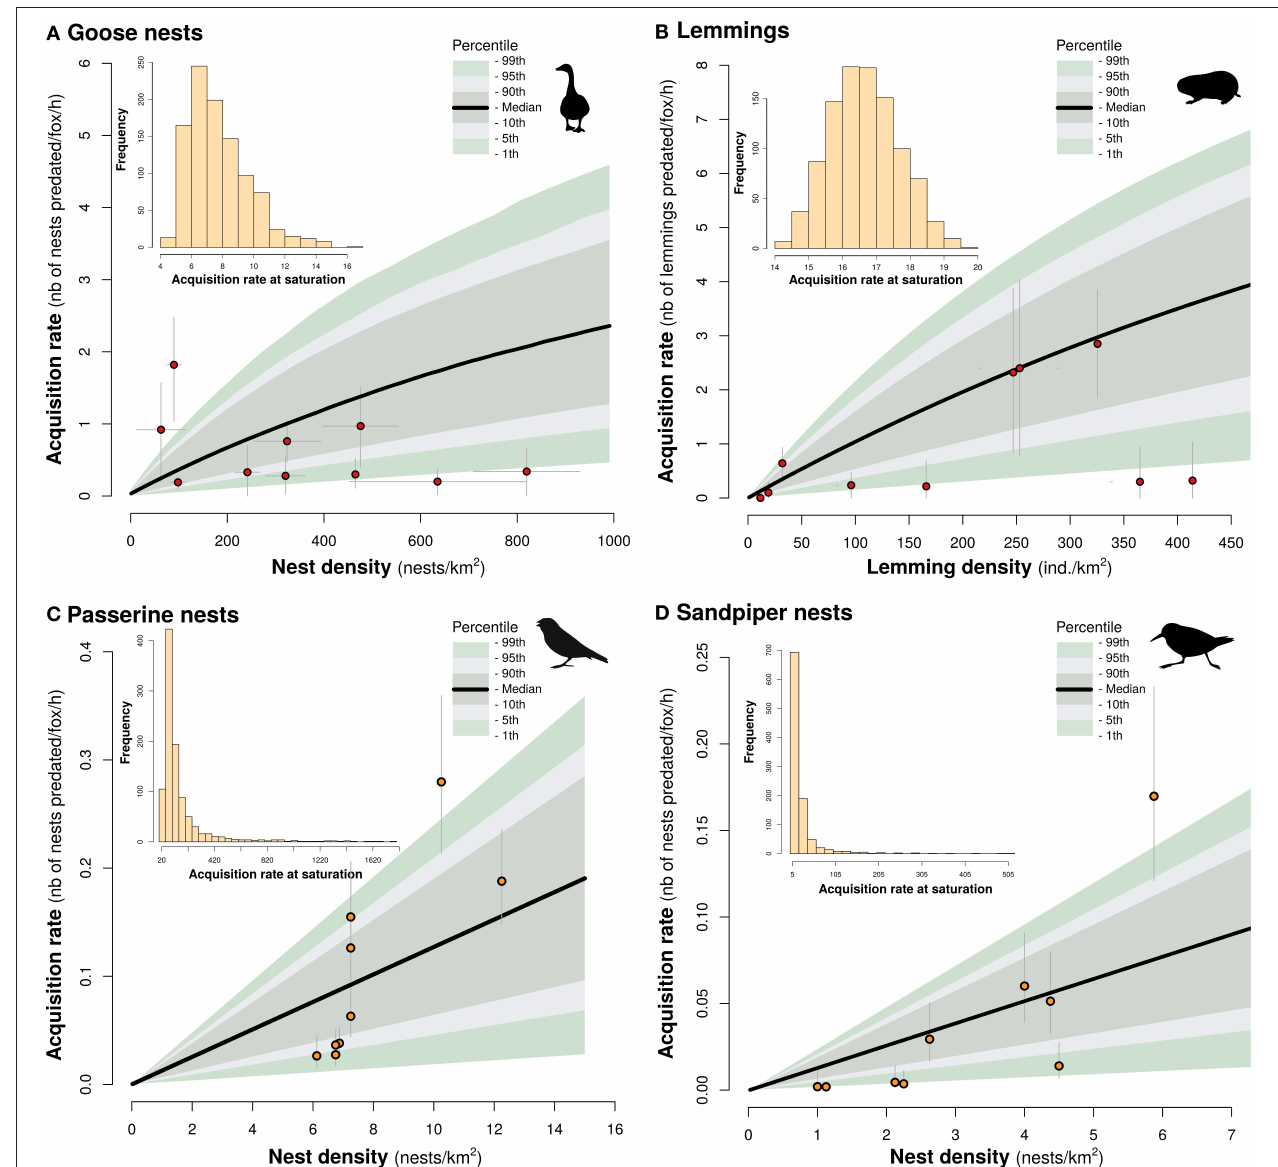
FIGURE 2 | Functional response of arctic fox to density of goose nests (A) , lemmings (B) , passerine nests (C) , and sandpiper nests (D) . Black lines represent the median of the mechanistic model and the color bands represent the 90th, 95th, and 99th percentiles based on 1,000 simulations. Empirical data are represented by red and yellow dots respectively. Histograms in the inset show the distributions of acquisition rate at saturation for each simulation. Horizontal error bars in (A) indicate the range of nest density during the incubation period. Vertical errors bars in (A,B) represent standard errors calculated using bootstrapping. Errors bars in (C,D) represent 95% confidence intervals from daily survival rate